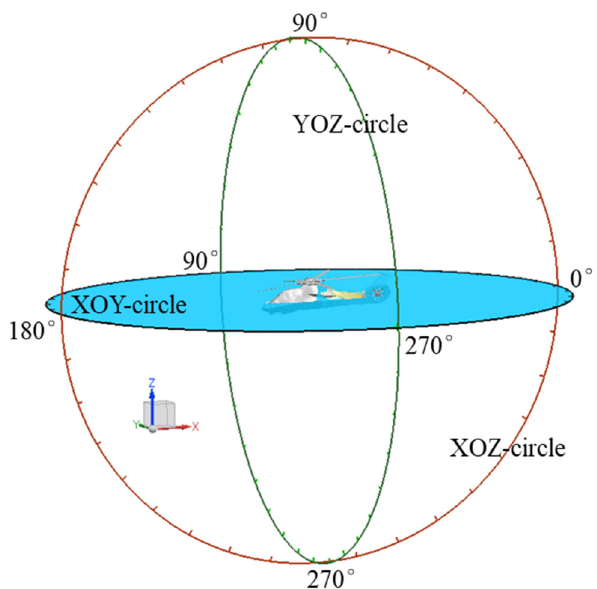
Figure 6. Distribution of infrared radiation detection points.